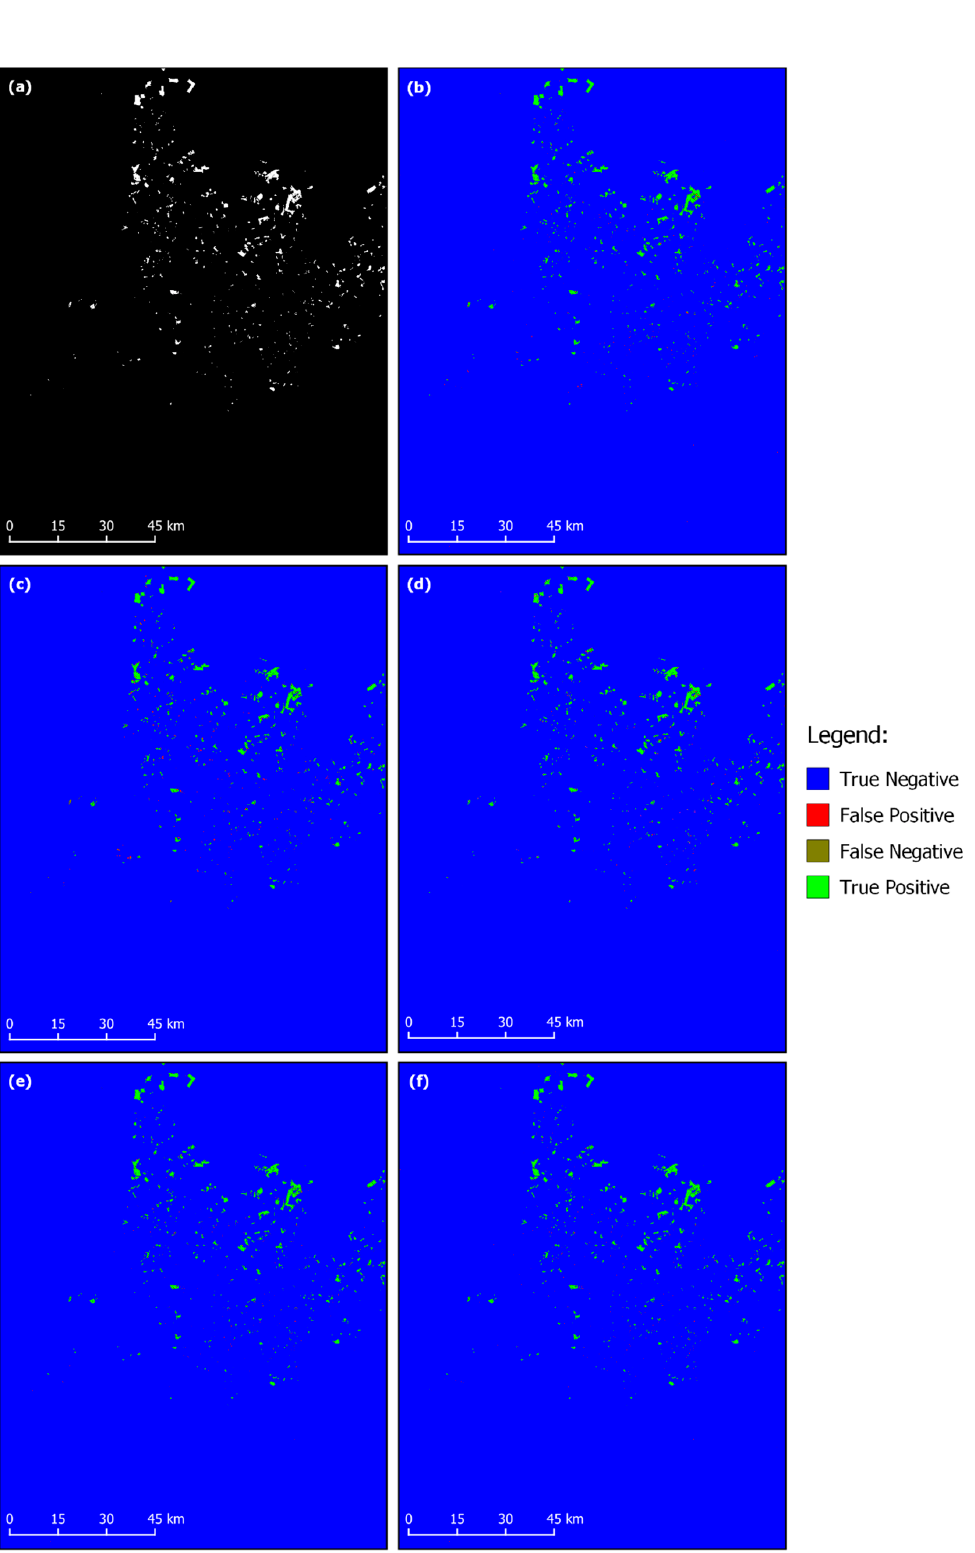
Figure 8. Deforestation masks according to the ( a ) ground truth and classifications produced by the ( b ) RF, ( c ) MLP, ( d ) SharpMask, ( e ) U-Net, and ( f ) ResUnet models in the 2018–2019 sequence.